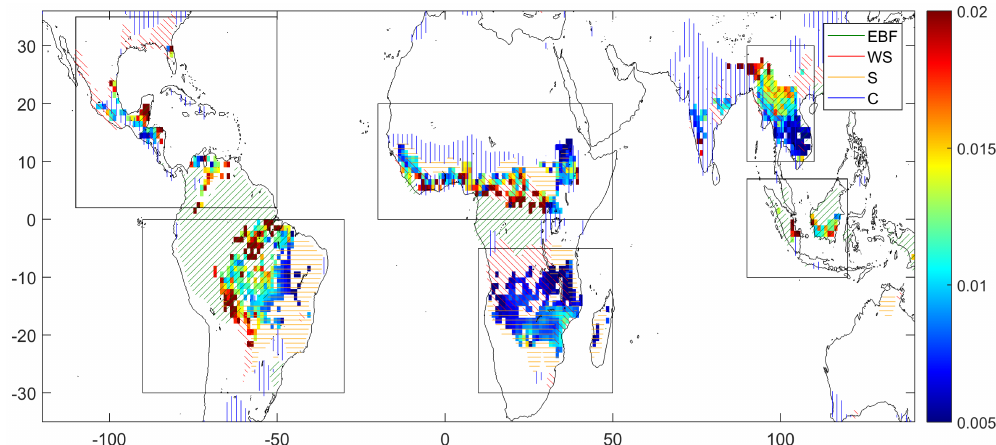
Figure 3. Mean yearly ER NH ratios averaged over the time period between 2008 and 2015 for the selected pixels. The four main biomes 3 / CO studied are represented by the hatched lines: savanna (S), woody savanna (WS), evergreen broadleaf forest (EBF), and crop together with the cropland/natural vegetation mosaic (C+CNVM), here called